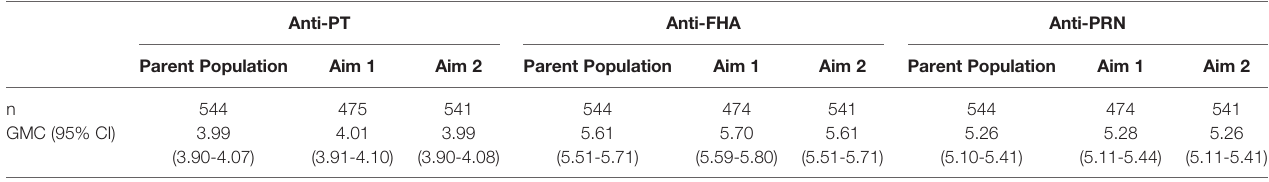
TABLE 3 | GMCs with 95% CIs measured in infants at delivery in total parent population (only 544 infants had information about antibody titers at delivery available) and study groups by aim.